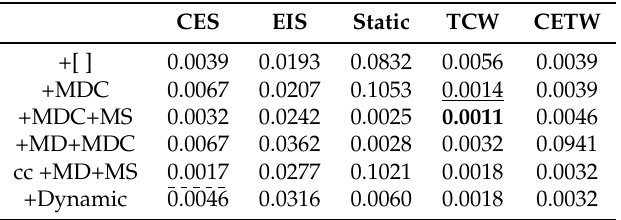
Figure 12. Generation errors of different classifiers with different feature datasets. Table 6. Errors of RAB-RBFSVM+ with different fire smoke